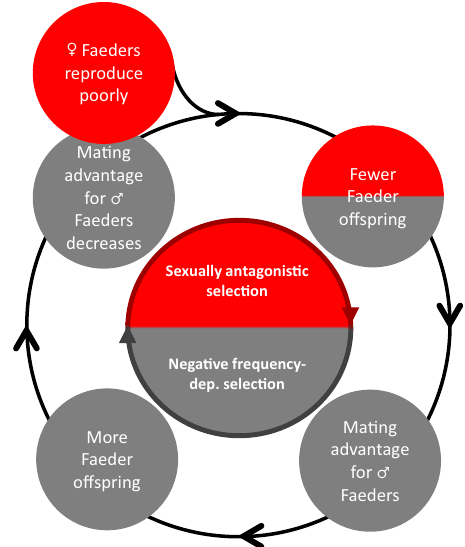
Fig. 4 Dynamic relationship between sexual antagonism and negative frequency-dependent selection represents a possible mechanism to stabilize the frequency of the Faeder allele in ruffs. As Faeder females have low reproductive success and produce few Faeder fl edglings, Faeder males bene fi t through negative frequency-dependent selection of their alternative reproductive tactic and produce more Faeder offspring. The spread of the Faeder allele will be limited by its sexually antagonistic effects on female reproductive output and negative frequency-dependent selection reducing the reproductive output of Faeder males when they become more (Fig. 4). Similarly, negative frequency-dependent selection in